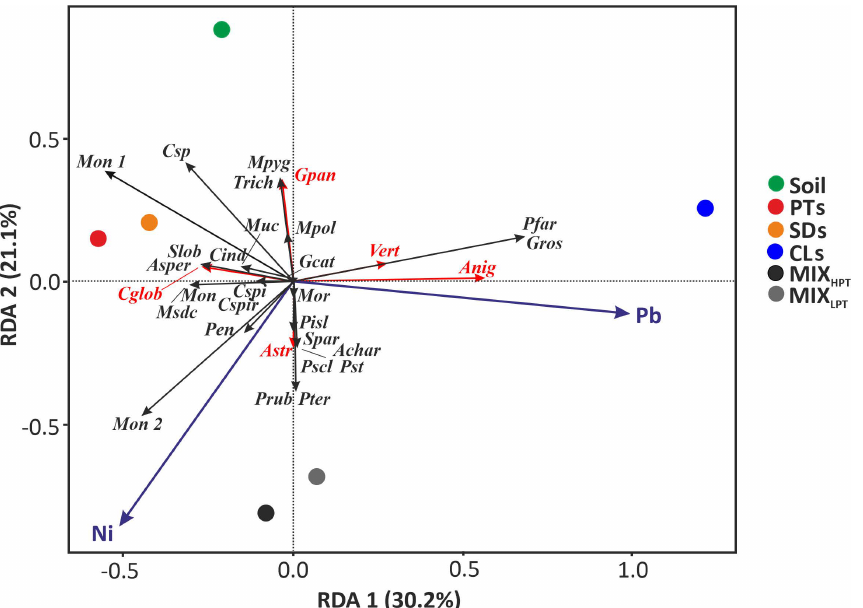
Figure 6. Ordination biplot of redundancy analysis for the fungi composition explained by Pb and Ni contents for the natural soil and soil-like materials. Non-pathogenic and pathogenic fungi are plotted as black and red arrows, respectively (fungi species abbreviations see in the Table 4).